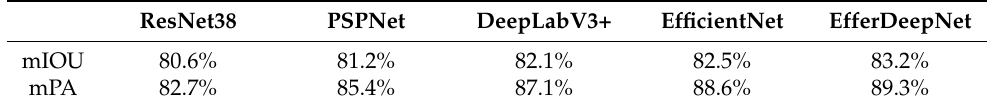
Table 4. Precision comparison between the proposed EfferDeepNet network and similar networks on the Cityscapes